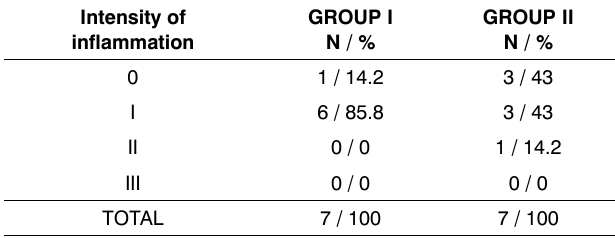
Table 2. Comparison between the right vocal fold (grafter) in group I and the right vocal fold (grafted) in group II: Compara- tive analysis of the intensity of inflammation in the grafted vocal folds in groups I and II